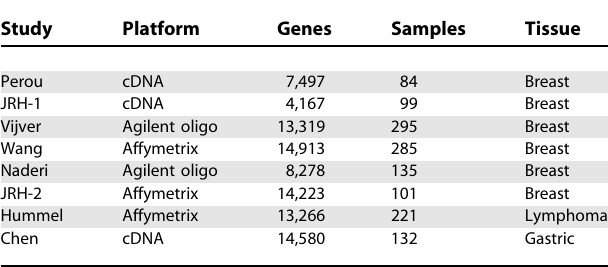
Table 1. Breast Cancer